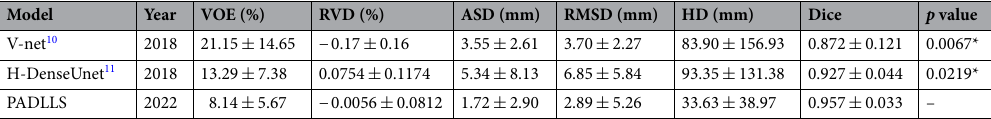
Table 1. Comparison of liver segmentation results on SLIVER07. An asterisk indicates a statistically significant difference in Dice score between our pipeline and another model ( p < 0.05).